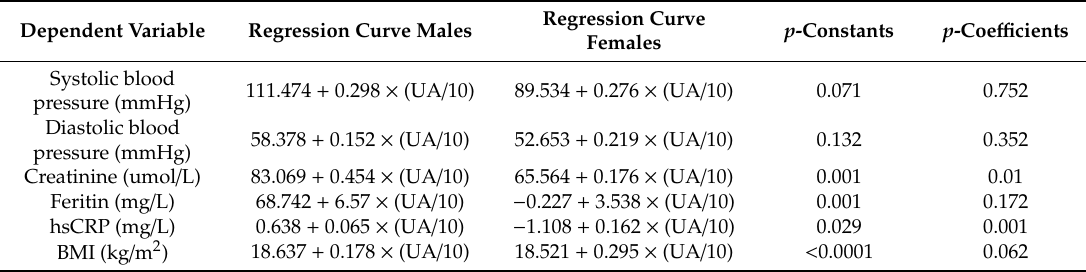
Table 8. The comparison of regression curves for variables significantly associated with uric acid in males and